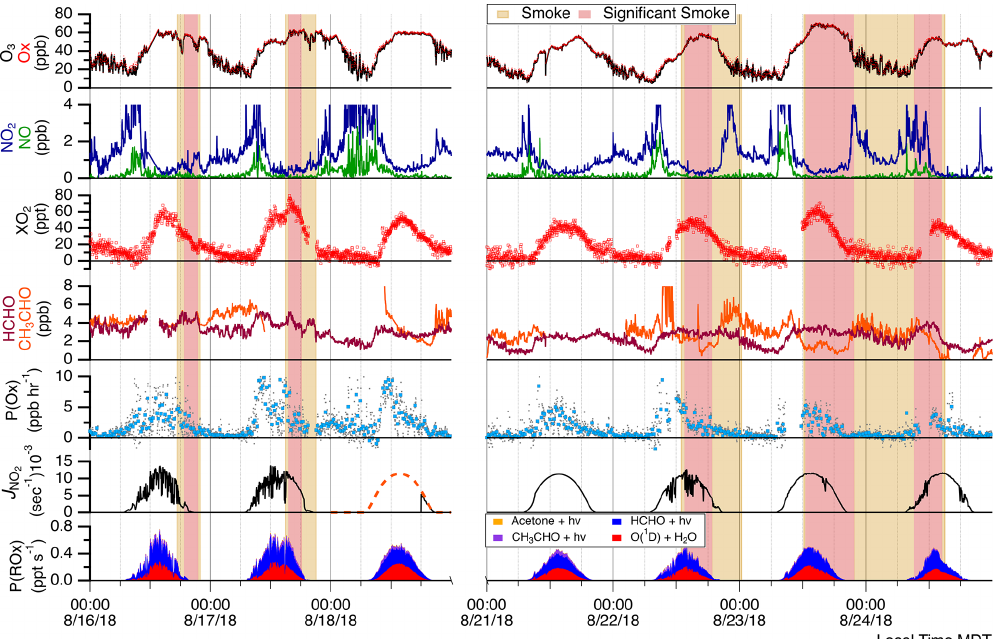
frequencies 2 trace is 2